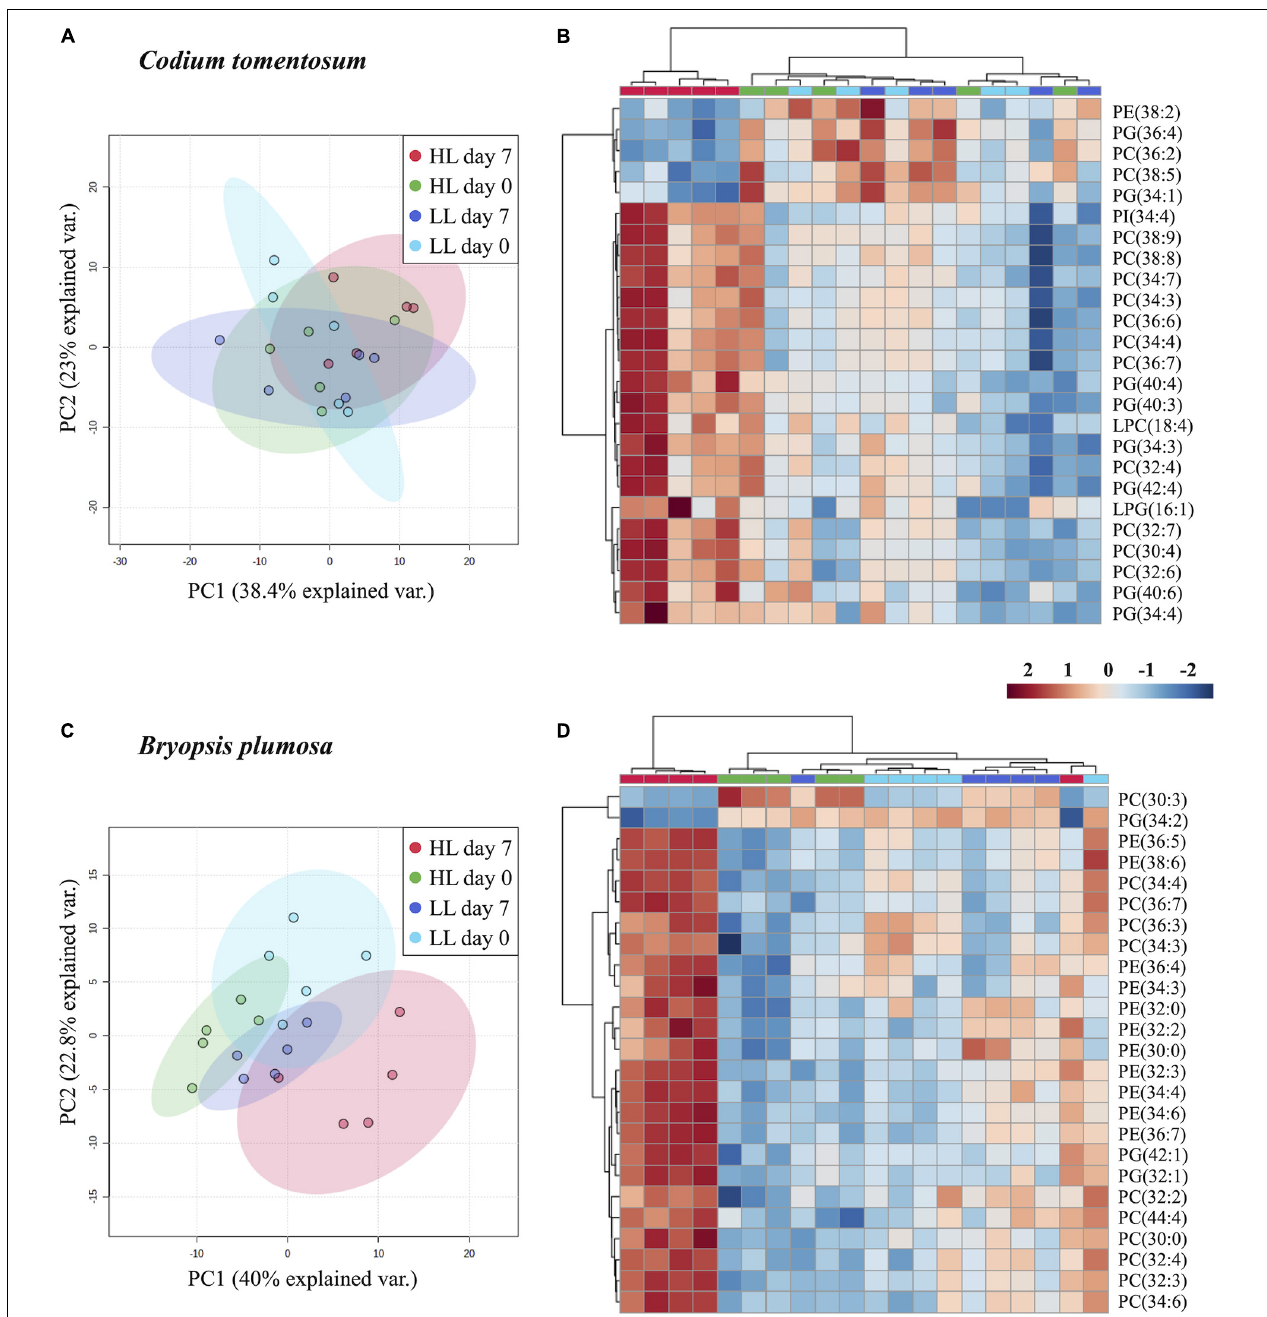
FIGURE 7 | Principal component analysis (PCA) and heatmap/clustering analysis of phospholipids profile discriminating macroalgae at low light (LL) and high light (HL) at the beginning (day 0) and at the end (day 7) of the light acclimation. (A) PCA 2D score plot— Codium tomentosum ; (B) heatmap/clustering— C. tomentosum ; (C) PCA 2D score plot— Bryopsis plumosa (D) heatmap/clustering— B. plumosa . PCA scores plot were performed using the complete phospholipids dataset (normalized XIC areas) while for heatmaps/clustering analysis the 25 molecular species that most contributed to differentiation between treatments were selected (PLS-DA